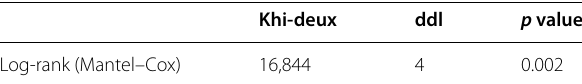
Table 3 Log-rank type test to compare survival according to each ISR restenosis treatment modality